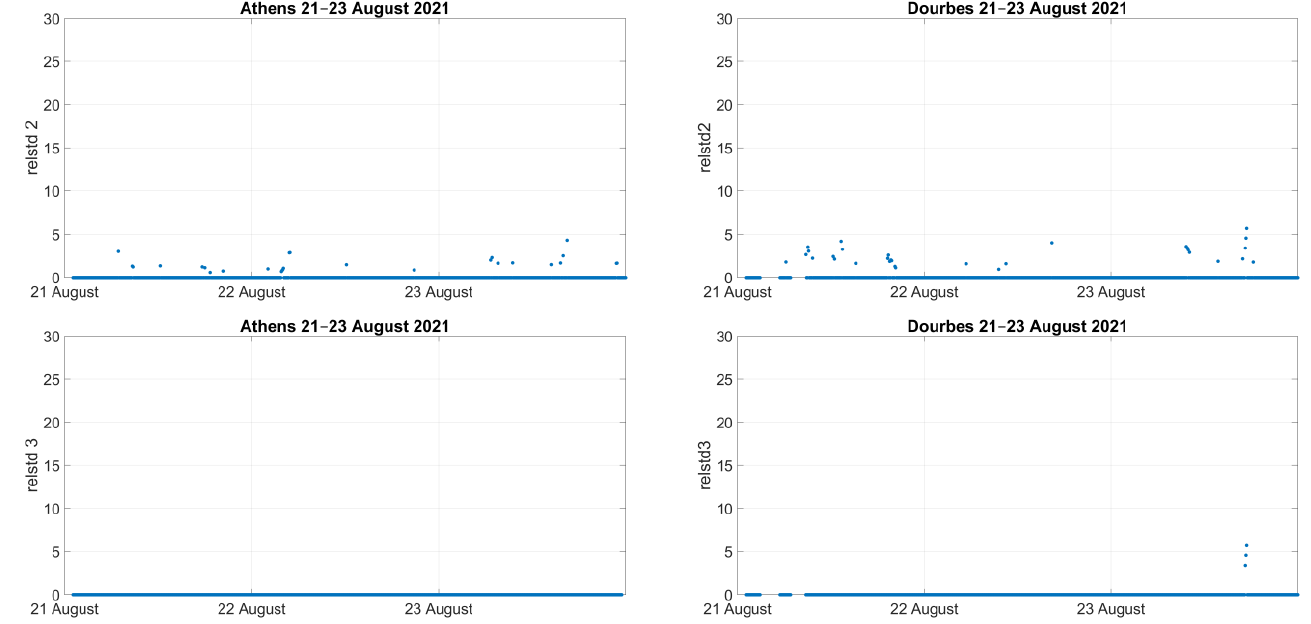
Figure 6. The variability of the relstds for the quiet period 21–23 August 2021, resulting from the application of the LSTID identification criteria (see paper text) over data collected from Athens (on the left) and Dourbes (on the right) Digisondes.